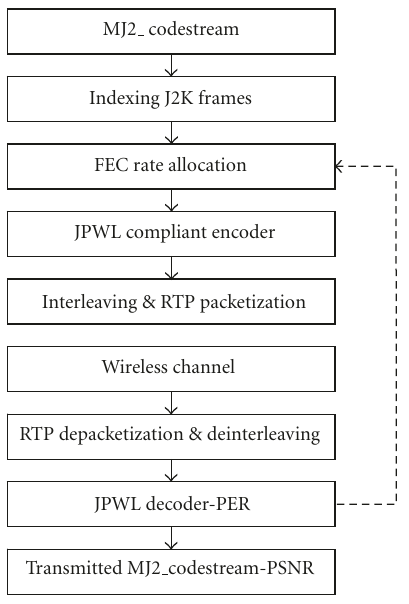
Figure 2: JPWL-based system